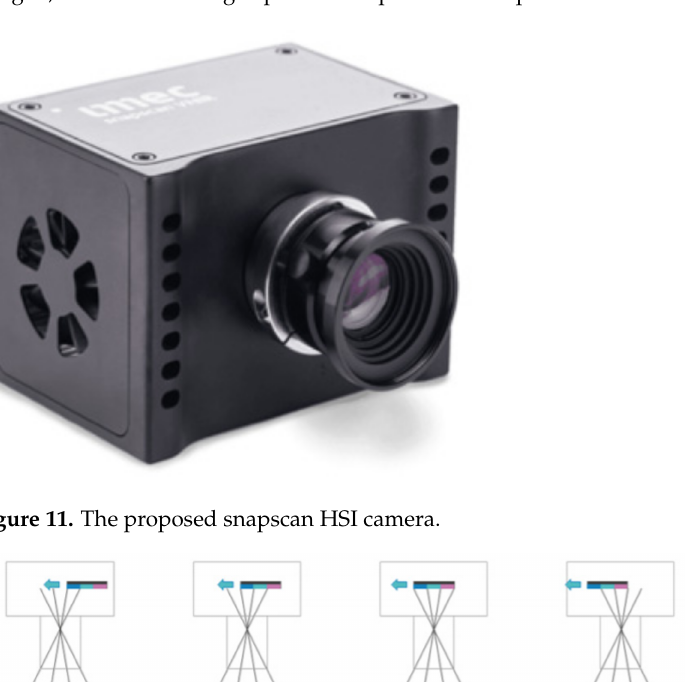
Figure 10. Example of one of our snapscan sensors and its spectral response. For this 100 + band HSI sensor, the spectral filters are deposited linearly across the sensors. By spatially scanning the scene imaged, HSI data with high spatial and spectral are acquired.